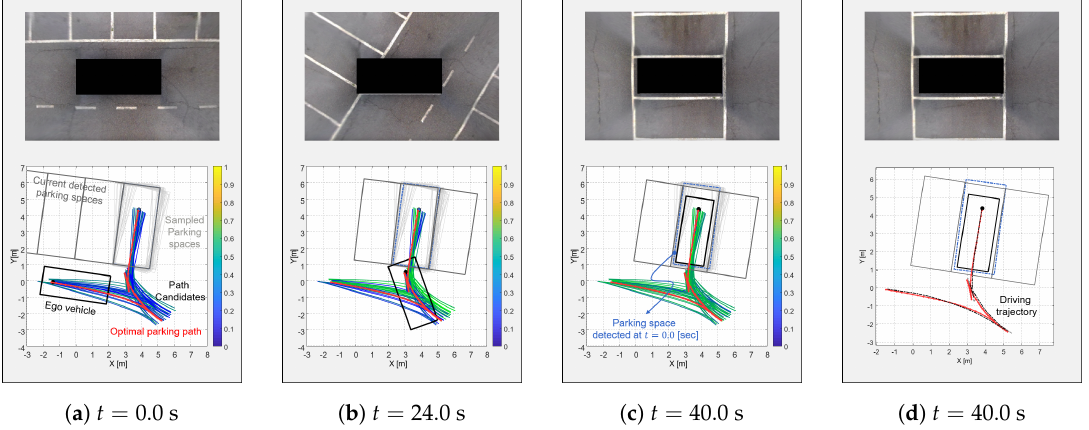
Figure 13. The open scenario with re-planning; there were also differences between the first and last detected parking spaces; however, the proposed algorithm changed the optimal path according to position and orientation